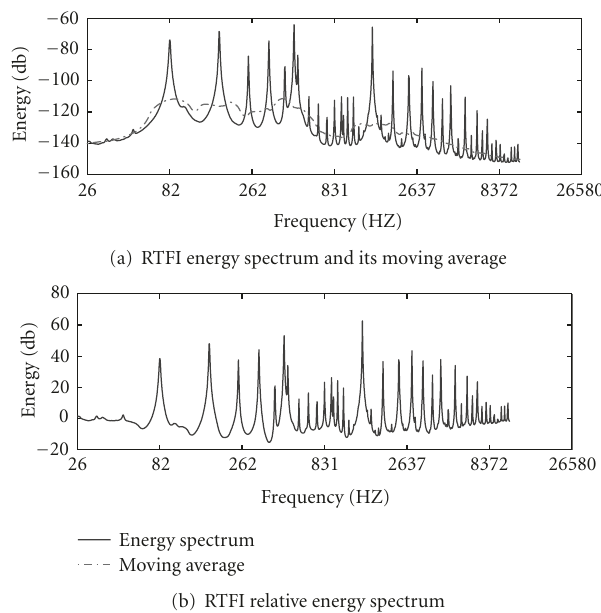
Figure 3: The input RTFI energy spectrum, moving average and the corresponding relative energy spectrum of a piano polyphonic note consisting of two concurrent notes with fundamental frequencies 82Hz and 466 Hz.